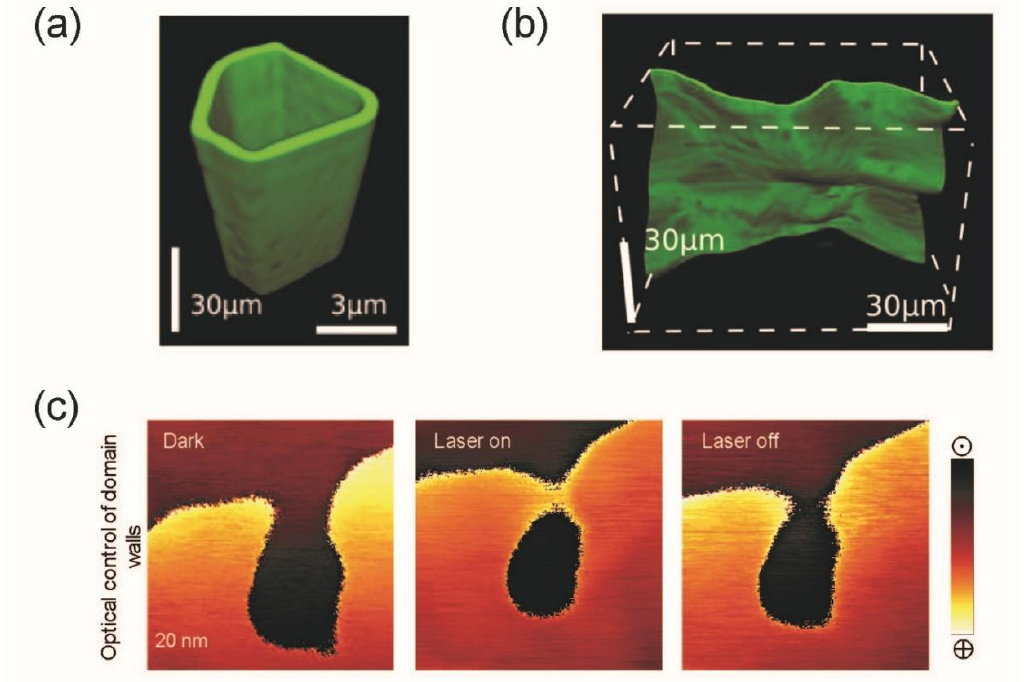
Figure 2. Optical 3D visualization of domain walls ( a , b ): Cherenkov second-harmonic generation (SHG) on LNO revealing the three-dimensional shape of 180 ◦ side-by-side ( a ) and head-to-head ( b ) domain walls [92]. Optical domain manipulation ( c ): Ferroelectric domain wall motion in KNN-BNNO [(K 0.5 Na 0.5 )NbO 3 ] x /[Ba(Ni 0.5 Nb 0.5 )O 3−δ ] 1-x induced by laser radiation due to photo-induced charging of the surface [93].